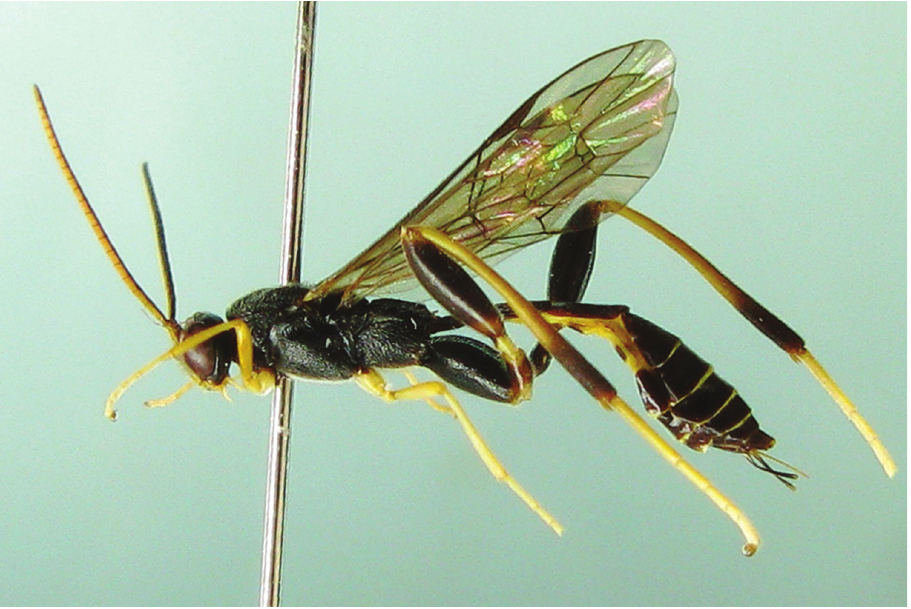
Figure 4. Bicurta sinica Sheng, Broad & Sun, sp. n., puncture, apical portion smooth, impunctate. Labrum crescentic, about 0.33 × as long as wide. Malar space with fine leathery texture, without subocular sulcus, approximate- ly 0.4 × as long as basal width of mandible. Gena glossy, with distinct fine punctures, in lateral view approximately 0.66 × as long as width of eye, evenly convergent backward. Posterior portion of vertex with fine punctures, portion between lateral ocellus and eye with fine leathery texture. Interocellar area slightly convex, with fine longitudinal wrin- kles. Postero-ocellar line approximately as long as ocular-ocellar line. Dorsolateral part of frons with fine punctures, distance between punctures about as long as diameter of puncture; median portion narrowly smooth longitudinally; ventral portion with weak median longitudinal carina reaching to median protuberance of face. Antenna 5 mm, with 20 flagellomeres, ratio of length of flagellomere 1:2:3:4:5 is 5.5:4.0:3.8:3.7:3.4; last flagellomere 3 × as long as wide, approximately as long as fourth flagellomere. Dis- tance from hypostomal carina to mandible about as long as basal width of mandible. Mesosoma. Anterior portion of pronotum with fine longitudinal wrinkles; dorsal portion slightly scabrous; near dorsomedian portion with transverse wrinkles, posterior sections of the wrinkles parallel dorsal margin of pronotum; ventral portion with dense transverse wrinkles. Epomia indistinctly differentiated from strong oblique wrinkles. Mesoscutum with fine punctures; punctures on middle lobe denser than on lateral lobe, distance between punctures 0.2 to 2.5 × diameter of puncture; distance between punctures on lateral lobe 0.5 to 3.5 × diameter of puncture; posterior median portion with longitudinal concave and transverse wrinkles. Scutellum with dense punctures, distance between punctures 0.2 to 0.5 × diameter of puncture. Postscutellum with rela-